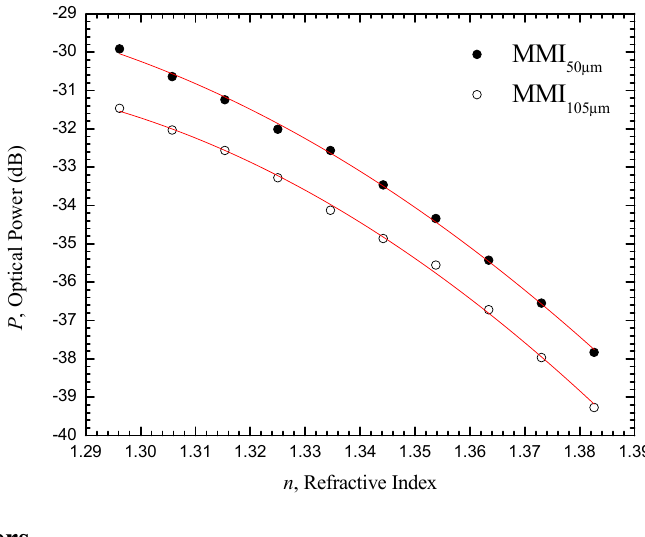
Figure 7. Variation of optical power, P , with refractive index, for MMI-based fiber tips with 50 and 105 μ m MMF core diameters,